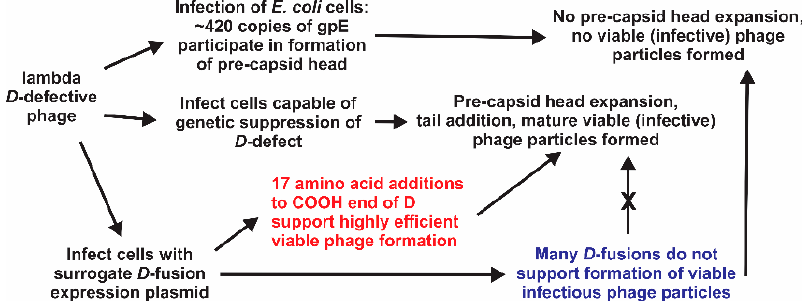
Figure 7. Summary gpD complementation. Fusing short epitopes at the COOH-end of gpD can permit very high e ffi ciency LDP recovery. Displaying single epitopes of about 17 amino acids can provide an e ffi cient method for preparing SEV, avoiding recovery problems that could be encountered when attempting to display larger polypeptide